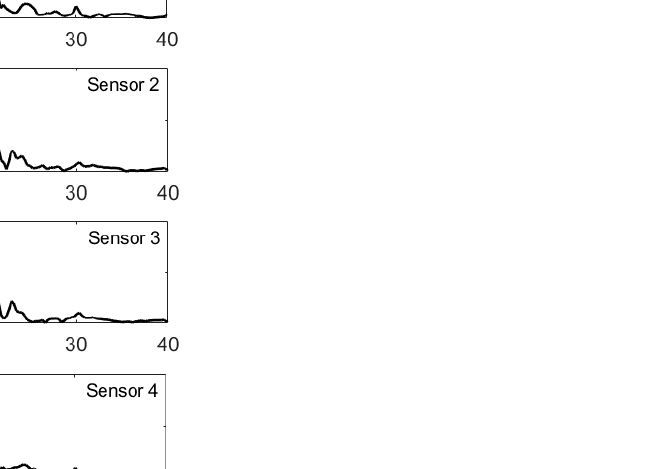
Figure 12. Frequency spectra, edge below impactor; expected frequency marked with dashed line.